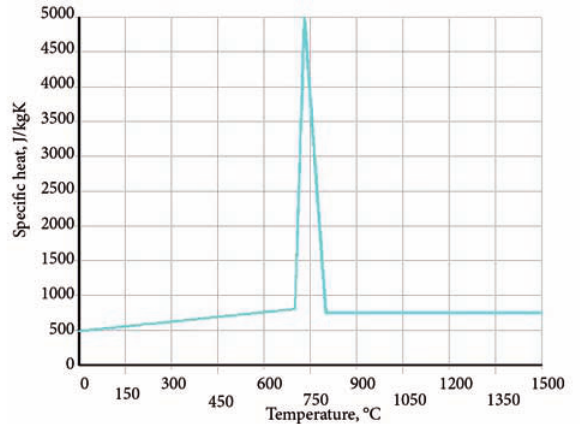
Fig. 4. Specific heat reliance on temperature